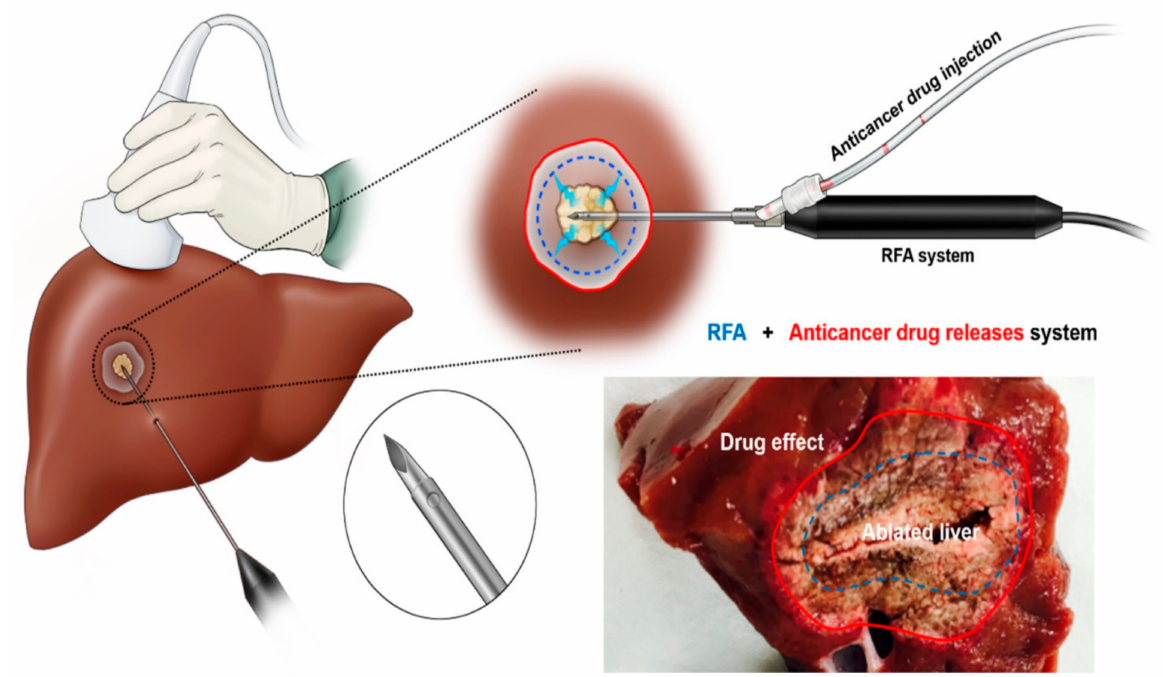
Figure 1. Schematic illustration of a radiofrequency ablation (RFA) system. The drug-releasing RFA system provides local ablation therapy with the delivery of anticancer